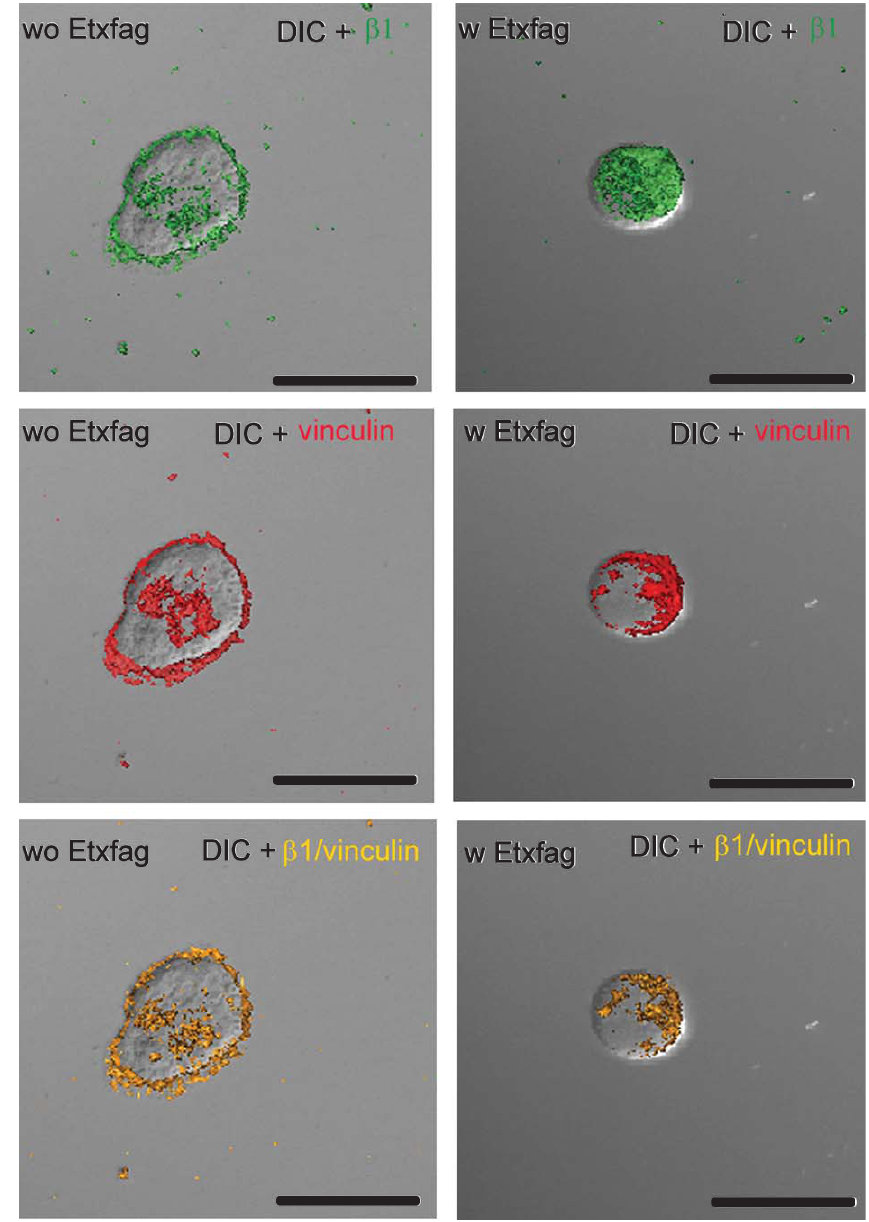
Fig. 4. Etxfag alters the number of focal adhesion complexes in L1210 cells. L1210 cells treated or not with 1 × 10 − 7 M etxfag during 24h were seeded to FN/V-coated glass culture slides in serum-free medium for 2h. Cells were fixed with 4% paraformaldehyde then incubated with anti- (cid:1) 1 primary antibody (1:100) and labelled with secondary antibody linked to Alexafluor 488 (green). Cells were also incubated with anti-vinculin primary antibody (1:100) and labelled with secondary antibody linked to Alexafluor 568-(red). Emitted fluorescence was detected through the appropriate wavelength window. Twenty images were captured with a 0.25 (cid:3) m z-step. Surfacic reconstructions were realized from L1210 cells treated with or without etxfag (right and left row, respectively). Differential interferential contrast imaging of L1210 cells treated or not by etxfag was proceeded (right and left row, upper panel). Upper panels represent (cid:1) 1 integrin labelling (green), middle panels represent vinculin labelling (red) and bottom panels represent colocalization between (cid:1) 1 integrin and vinculin (gold). A representative image of three independent experiments is shown. Scale bar: 10 (cid:3)